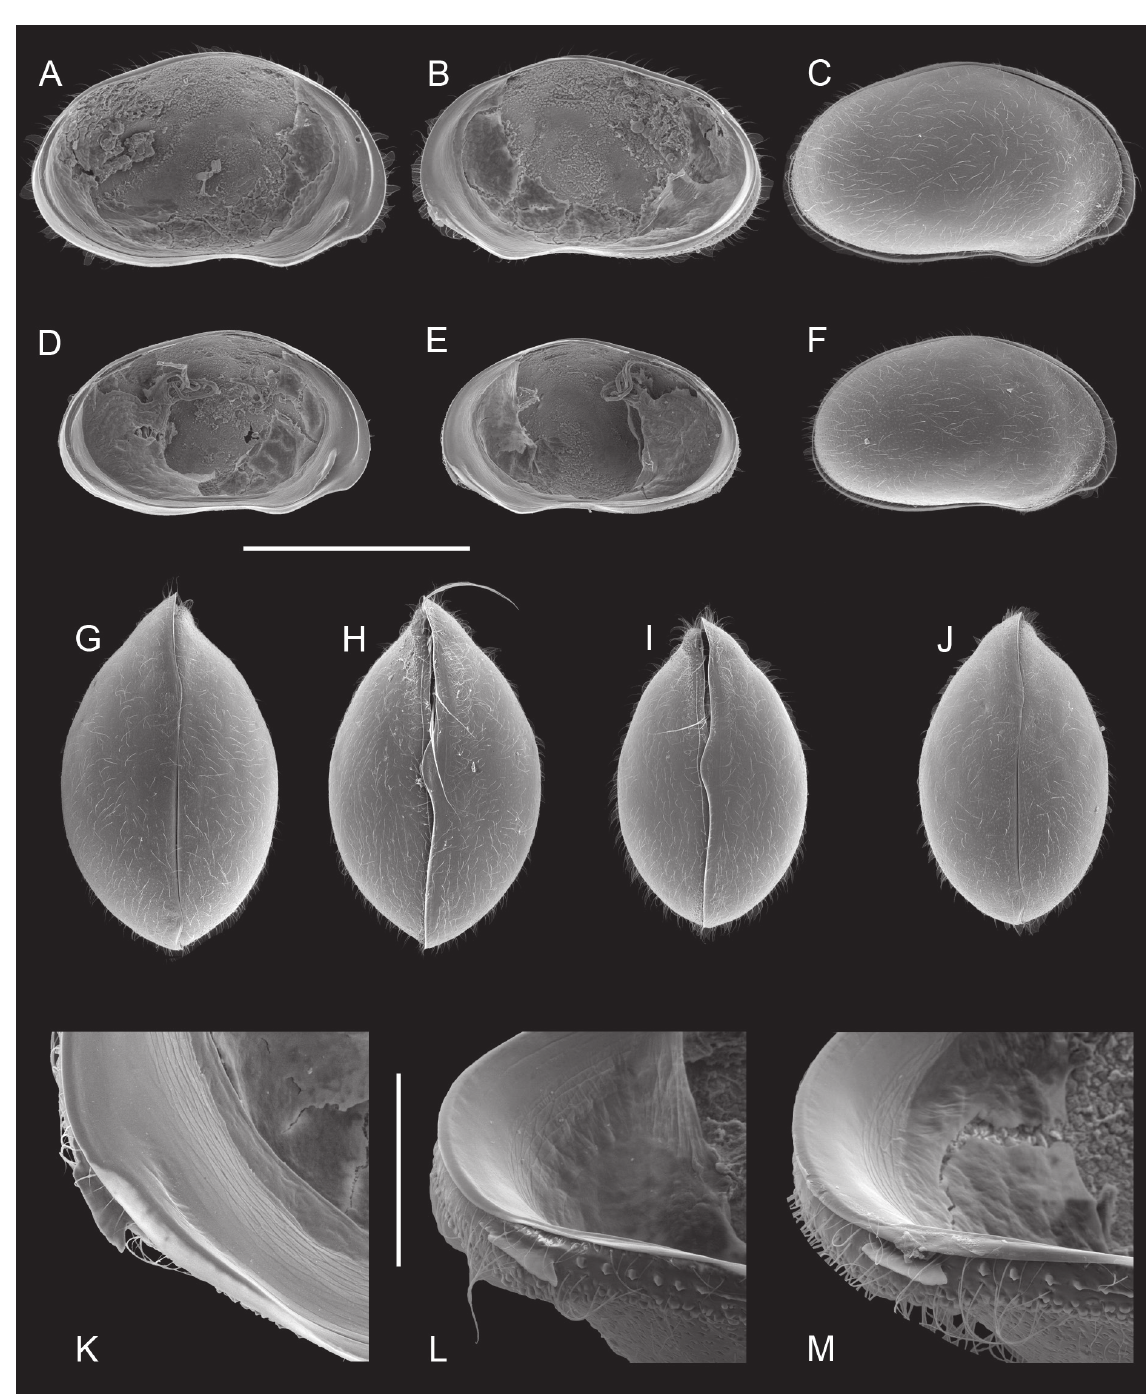
Fig. 4. Bennelongia timmsi sp. nov., all represent paratypes from Wave rock (BVt/10/05 – type locality). A . ♀, LVi (OC.3313). B . ♀, RVi (idem). C . ♀, CpRL (WAMC52235). D . ♂ holotype, LVi (WaMc52228). E . ♂ holotype, RVi (idem). F . ♂, CpRL (WAMC52236). G . ♀, CpD (WAMC52234). H . ♀, CpV (OC.3315). I . ♂, CpV (OC.3316). J . ♂, CpD (WAMC52237). K . ♂ holotype, RVi, detail anterior (WaMc52228). L . ♂ holotype, RVi, detail anterior, tilted (WAMC52228). M . ♀, LVi, detail anterior, tilted (Oc.3313). scales: a-J = 1 mm; K-M = 200